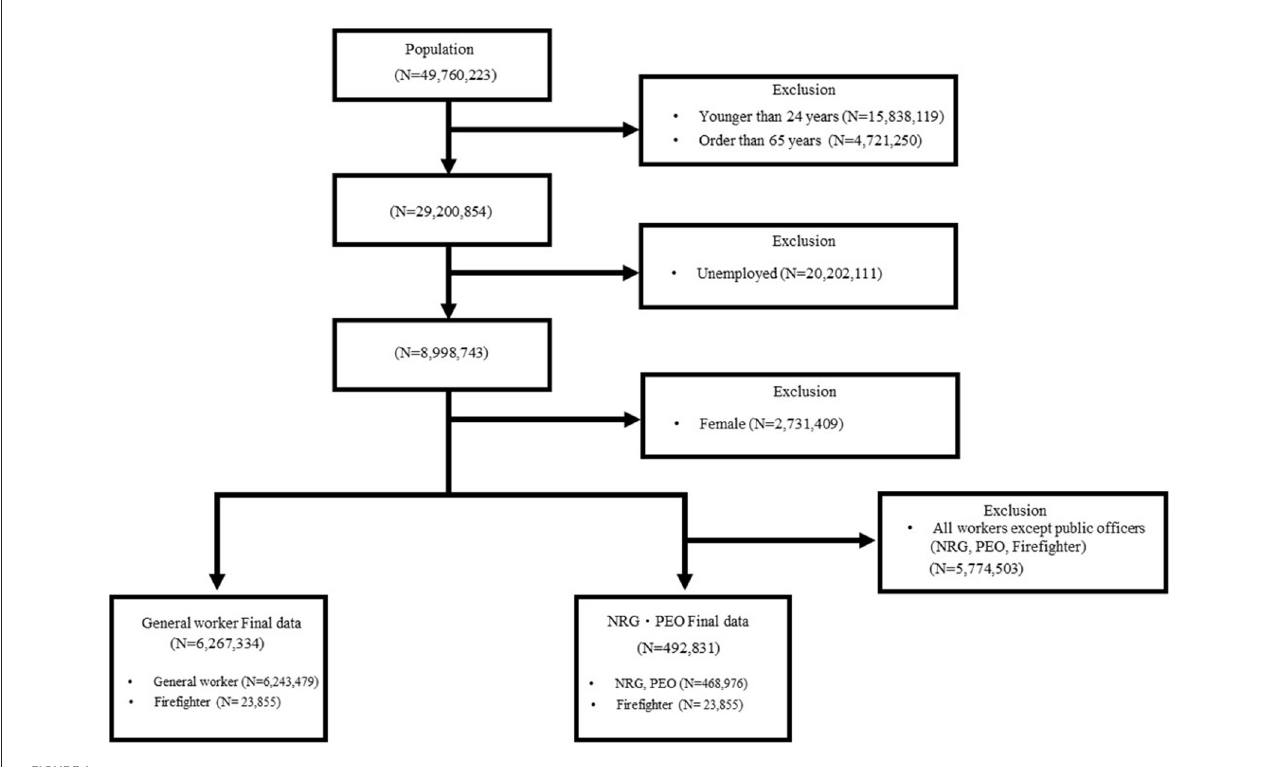
FIGURE1 Process used to select the study